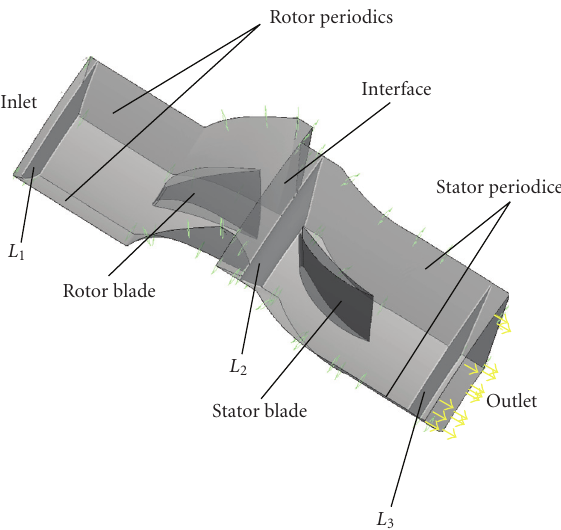
Figure 2: Flow domain with the given boundary conditions. Table 3: Spanwise Variation of